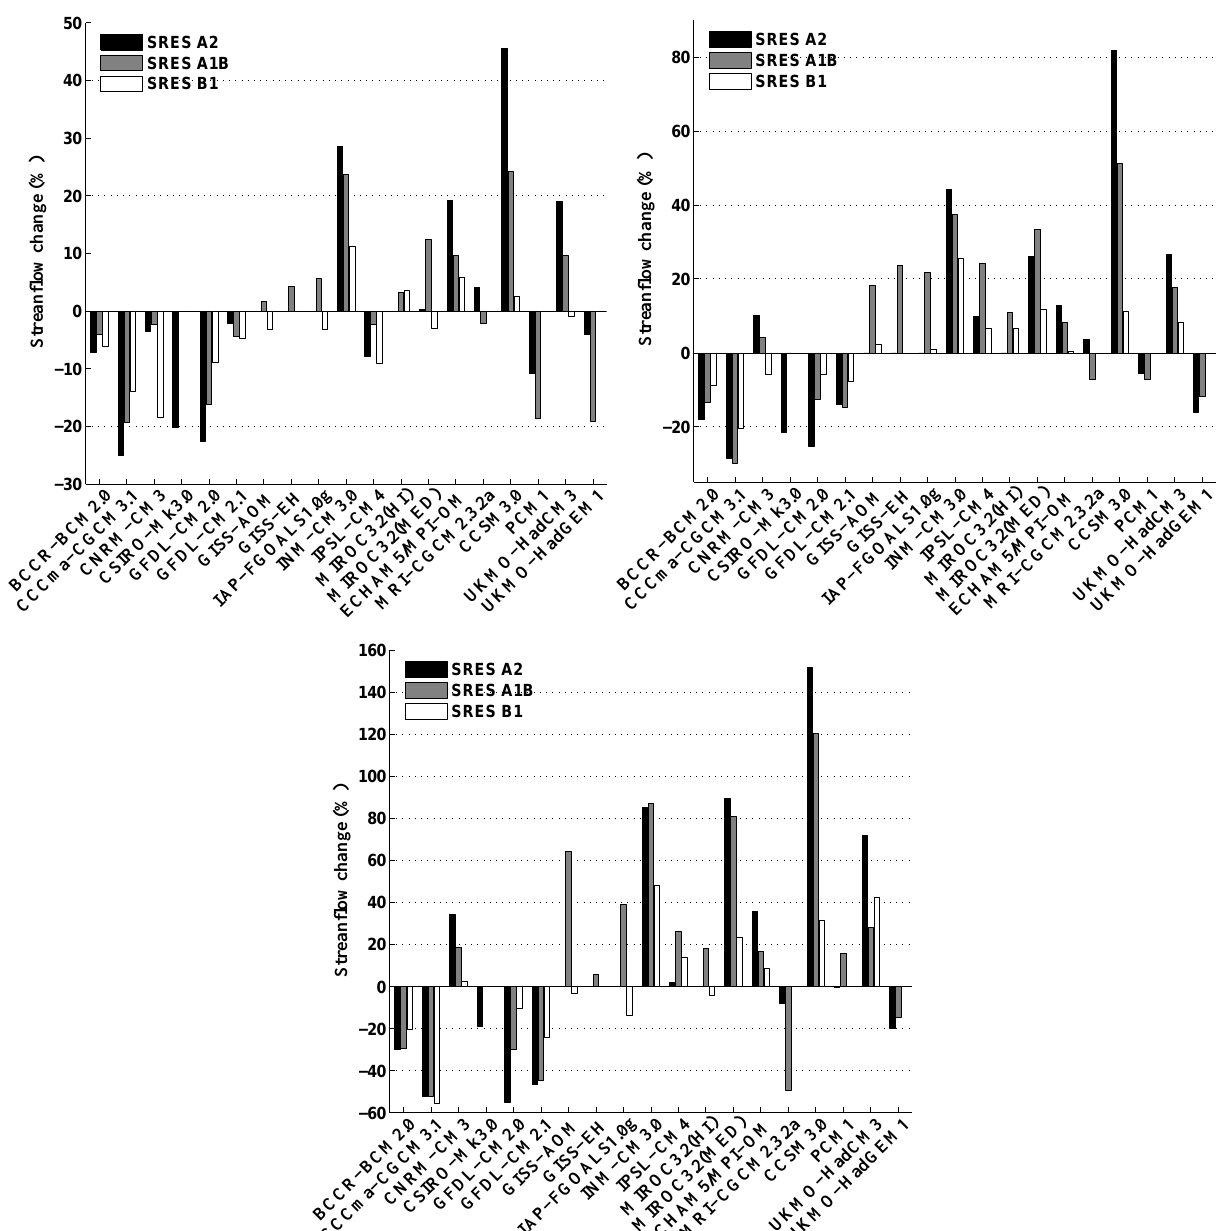
Fig. 12. Change in annual streamflow (%) for the (a) Baro Akobo, (b) Abbay and (c) Tekeze basins using the calculated combined temperature-precipitation sensitivities and precipitation and temperature changes (2081–2100 compared to 1981–2000) from 19 AOGCMs and three emission scenarios (totally 47 simulations for each